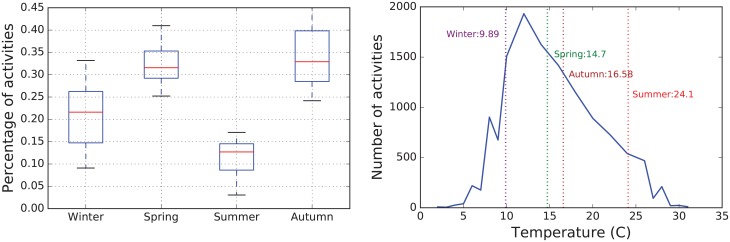
Analysis of hiking activities.Seasonal frequency of hikings for the four seasons (left). The number of hiking activities as a function of the average temperature of the day (right). Vertical dotted lines represent the averaged seasonal temperature.